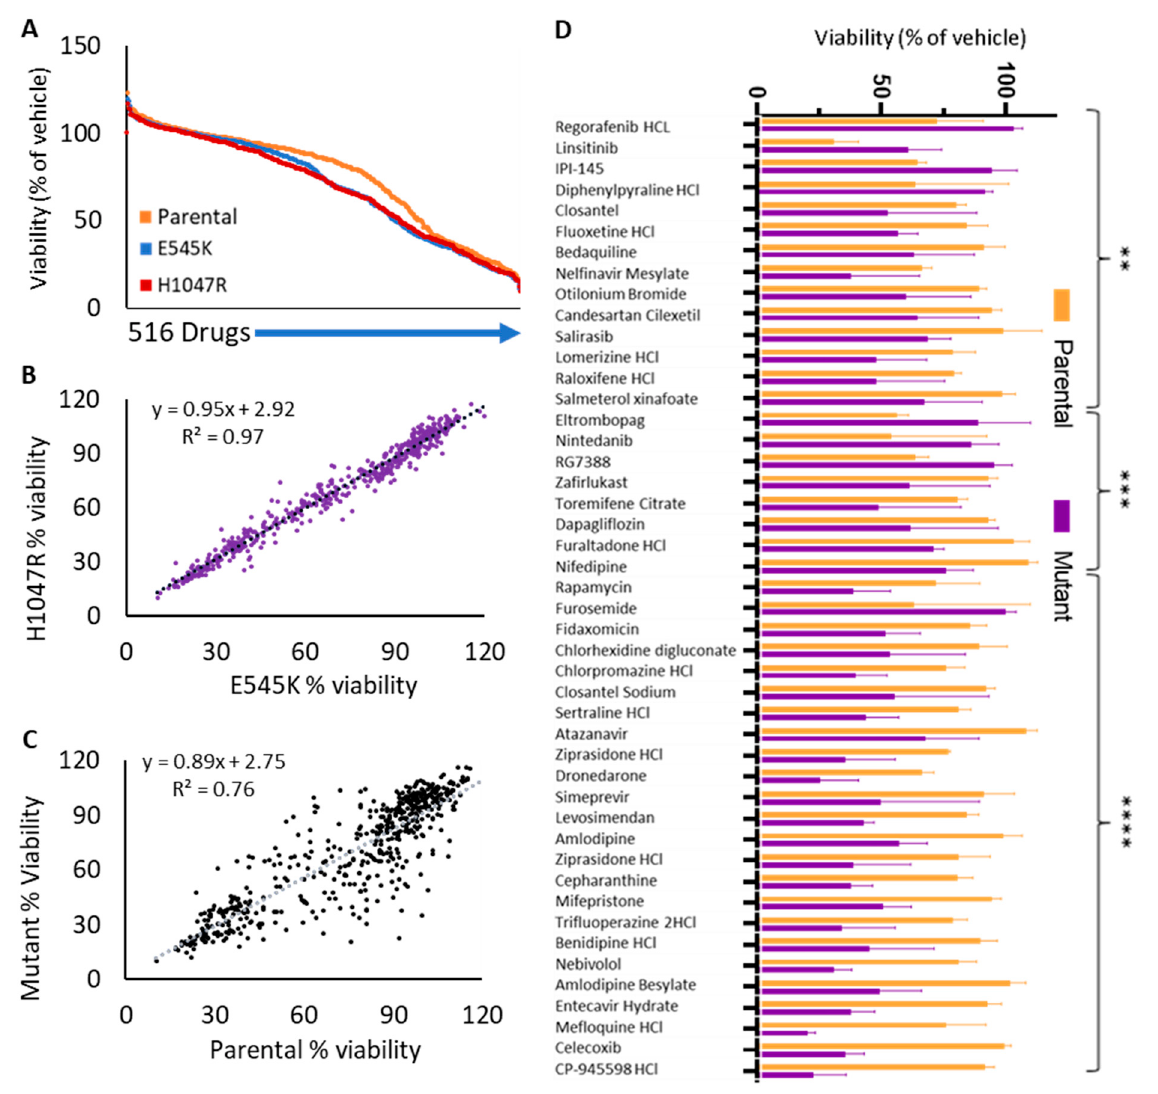
Figure 5. High throughput viability screening of 516 drugs on MCF10A WT , MCF10A E545K , and MCF10A H1047R revealed drugs that were more differentially effective relative to PIK3CA mutation status. ( A ) Drugs on each variant are ranked by model by viability. ( B ) Each drug’s effect on the viability of both mutant-containing models was compared. ( C ) The average of both mutant-containing models’ viability when treated with each drug compared to parental viability for that drug. ( D ) Significant ( p < 0.01) drugs when comparing MCF10A WT viability to that of the average MCF10A mutant viability. (** denotes p < 0.01, *** denotes p < 0.001, **** denotes p < 0.0001).